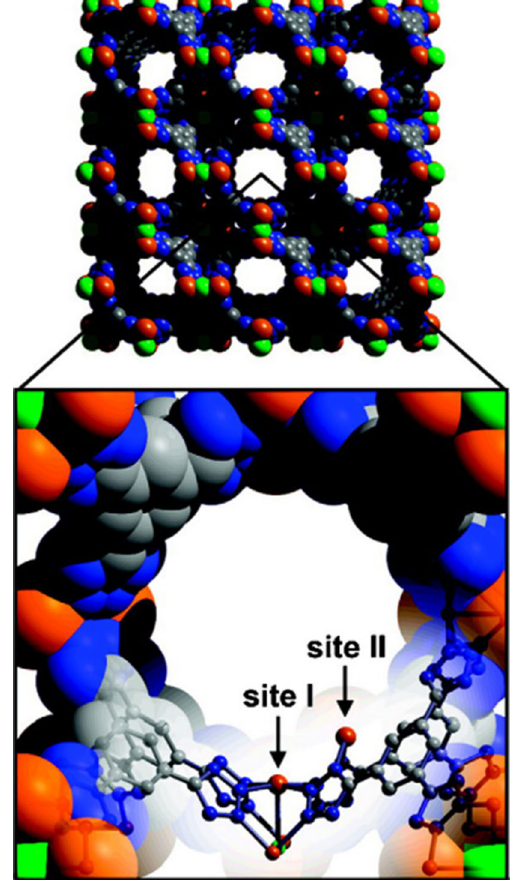
Fig. 1 Portion of a crystal structure showing two different types of Mn(II) sites exposed within its three-dimensional pore system of 10 Å wide channels. Site I is five coordinate, while site II is only two coordinate; the separation between them is 3.420(8) Å. (Adapted from Kuppler et al.